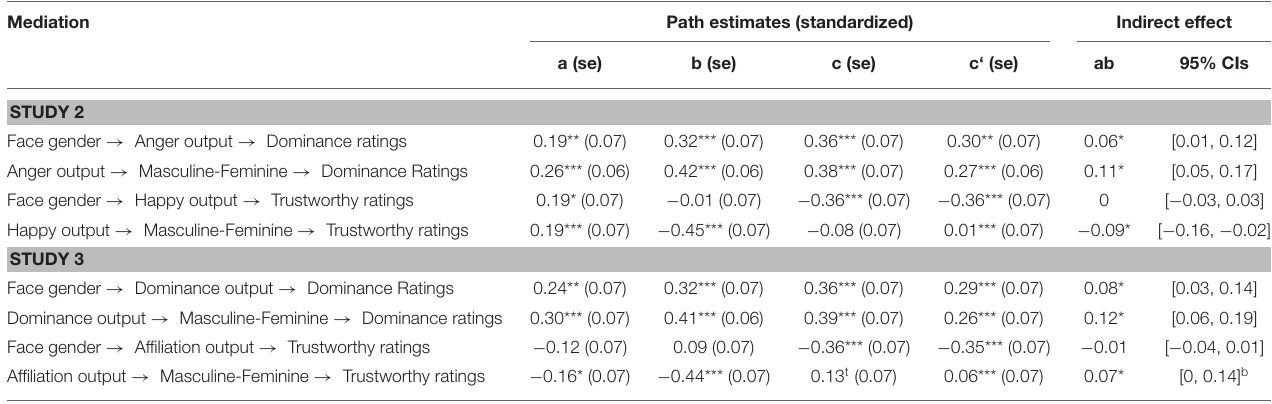
TABLE 1 | Standardized regression estimates for mediation models presented in Studies 2 &